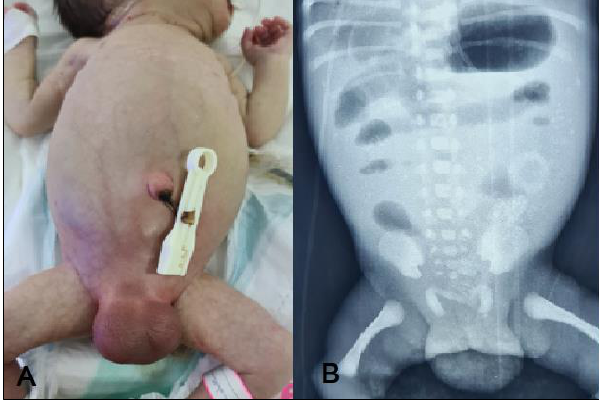
Figure 1: A) Neonate with Aphallia and abdominal distension. B) X-ray showing multiple air-fluid